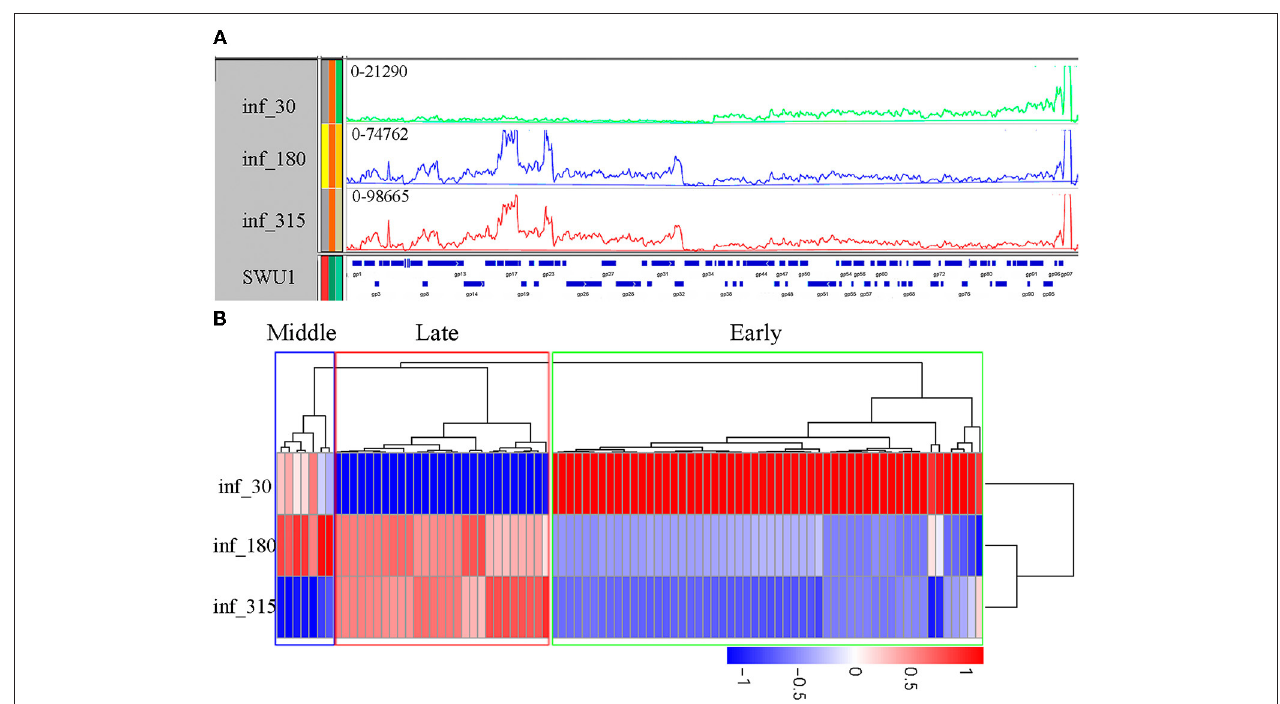
FIGURE 1 | Transcription of the SWU1 genome determined by RNA-seq. (A) Transcription patterns in the SWU1 genome determined by RNAseq. RNA was isolated during early SWU1 infection (green), middle SWU1 infection (blue), and late SWU1 infection (red). At all time points, one sample was taken for sequencing (Illumina HiSeqTM2000). The Y-axis is the number of RNAseq reads. The X-axis is the map of the SWU1 genome. (B) Cluster analysis of differentially expressed genes of SWU1. Based on log 10 (RPKM + 1), we cluster the differentially expressed genes in different phase of SWU1 infection. Red stands for high expressed genes; blue stands for low expressed genes. In early phase of SWU1 infection, a lesser number of genes were transcribed. Most of genes transcribed were located on the right arm of SWU1 genome. In middle and late phase of SWU1 infection, most of genes transcribed were located on the left arm of SWU1